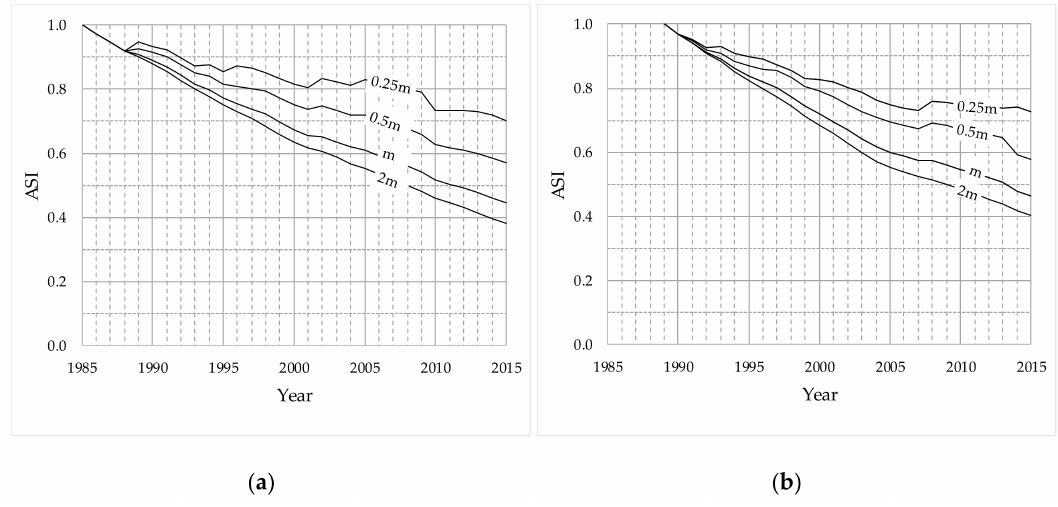
Figure 10. Sensitivity analysis of ASI index: ( a ) Asset 1; ( b ) Asset 2.